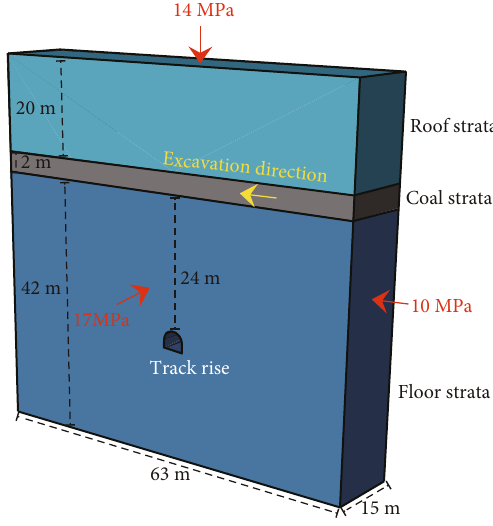
Figure 2: Numerical calculation